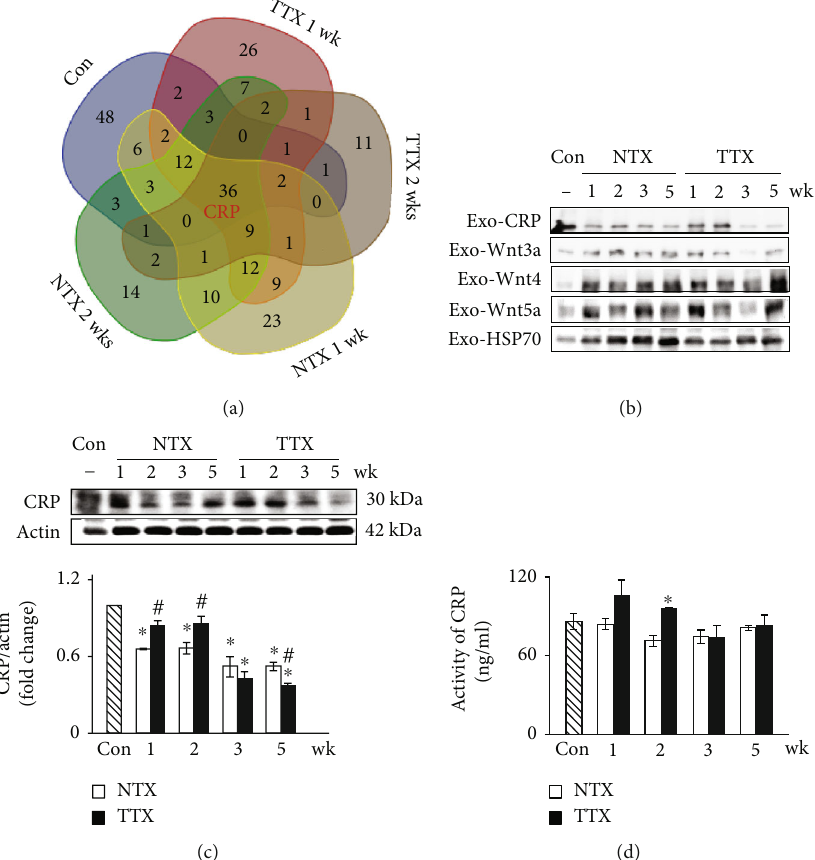
Figure 1: Increased CRP and Wnt ligands from exosomes by PD-MSC transplantation in bile duct-ligated rats. Exosomes were precipitated from BDL rat serum by LC-mass spectrometry (a). The expression of CRP and Wnt ligands from exosomes was normalized by HSP70 in rat serum after PD-MSC transplantation (b). The protein levels of CRP were determined by Western blot (c) and ELISA (d) after PD-MSC transplantation ( n = 3 per group, ∗ Con and # NTX vs. p < 0 : 05 ). Data were represented as the mean ± SD . CRP: C-reactive protein; HSP70: heat-shock protein 70; Con: control group; NTX: PD-MSC nontransplanted group; TTX: PD-MSC transplanted group; wk: